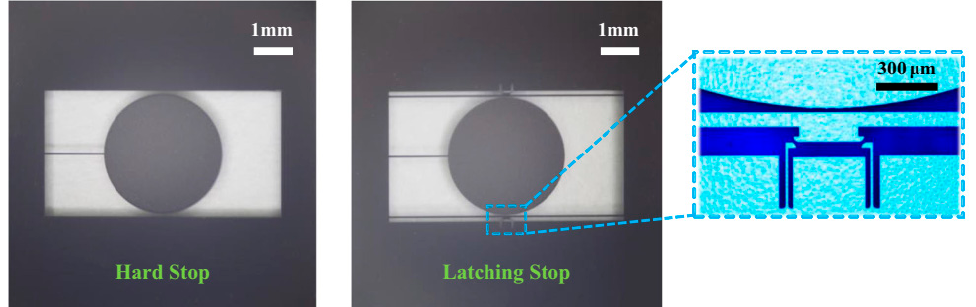
Figure 9. Processing and pictures of anti-shock latching structure [89].